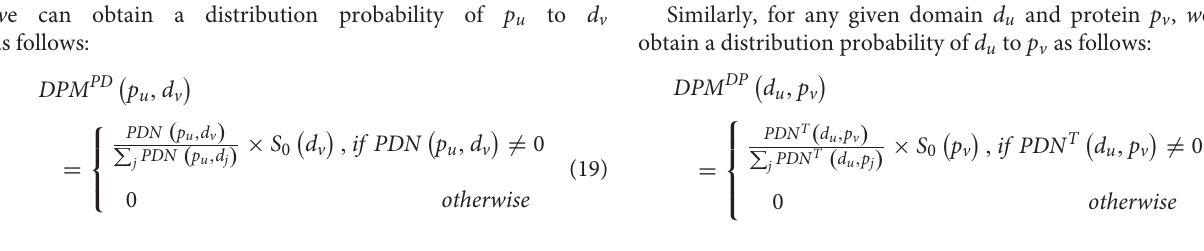
w e can obtain a distribution probability of p u to d